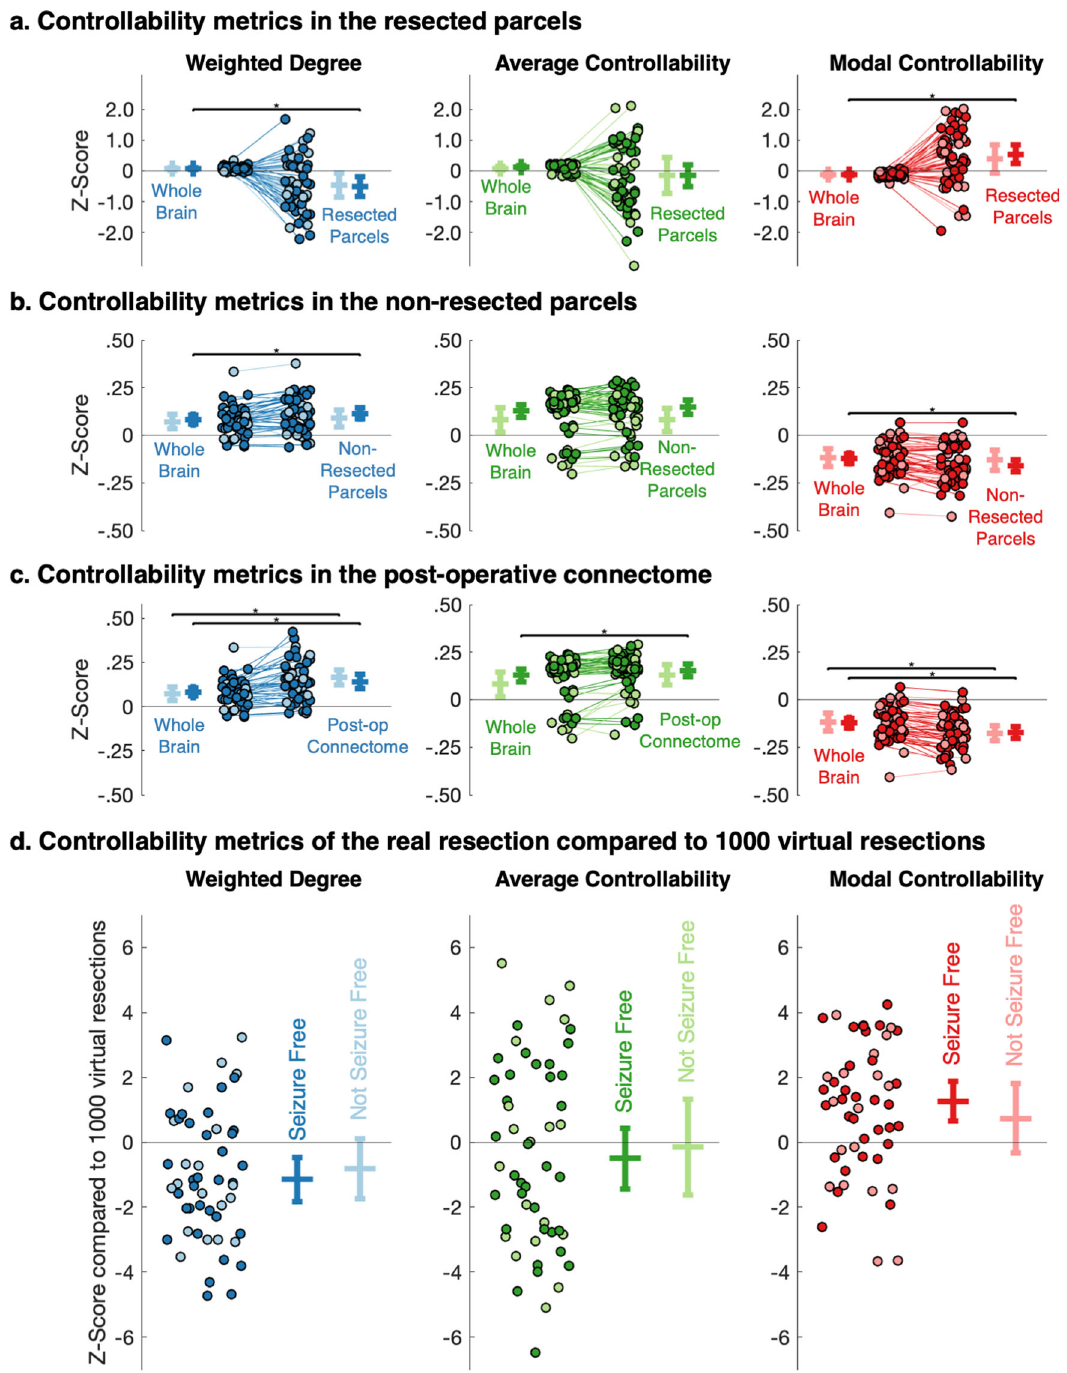
Fig. 6 Resected parcels in seizure-free patients show a lower weighted degree and higher modal controllability than equivalent parcels in controls and compared to virtual resections in patients. a – c Changes in the mean Z scores for weighted degree, average controllability and modal controllability for each resective surgery patient between baseline, the a resected parcels, b the non-resected parcels and c the post-operative connectome. There were signi fi cant differences in the mean weighted degree ( p = 0.002 and p = 6 × 10 − 4 ) and modal controllability ( p = 6 × 10 − 4 and p = 4 × 10 − 4 ) for both resected and non-resected parcels in seizure-free patients only (paired t tests, adjusted for multiple comparisons using the Benjamini – Hochberg FDR method). For the post-operative connectome, there were signi fi cant differences in the mean weighted degree for both seizure-free and not seizure-free patients ( p = 5 × 10 − 4 and p = 3 × 10 − 5 , respectively), mean average controllability in seizure-free patients only ( p = 0.001) and mean modal controllability for both seizure-free and not seizure-free patients ( p = 3 × 10 − 6 and p = 4 × 10 − 5 , respectively) (paired t tests, adjusted for multiple comparisons using the Benjamini – Hochberg FDR method). d Z scores of weighted degree, average controllability and modal controllability for the real resection compared to 1000 virtual resections for each of the patients, strati fi ed by post-operative outcome. Bars show mean ±95% con fi dence intervals. The real resection parcels were signi fi cantly different from 0 for weighted degree ( p = 0.007) and modal controllability ( p = 0.002) in seizure-free patients only (one-sample t tests, adjusted for multiple comparisons using the Benjamini – Hochberg FDR